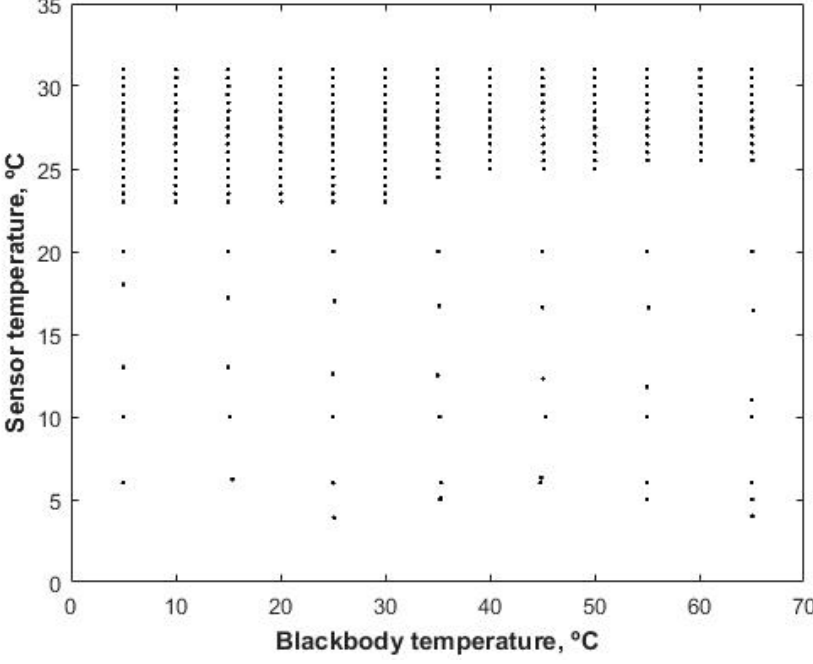
Figure 3. Range of thermal camera temperature and blackbody temperature analysed.